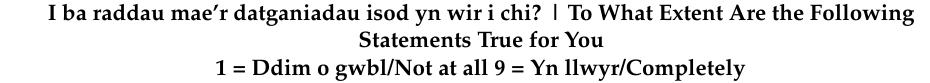
Table A1. Accent and pronunciation items in the questionnaire.